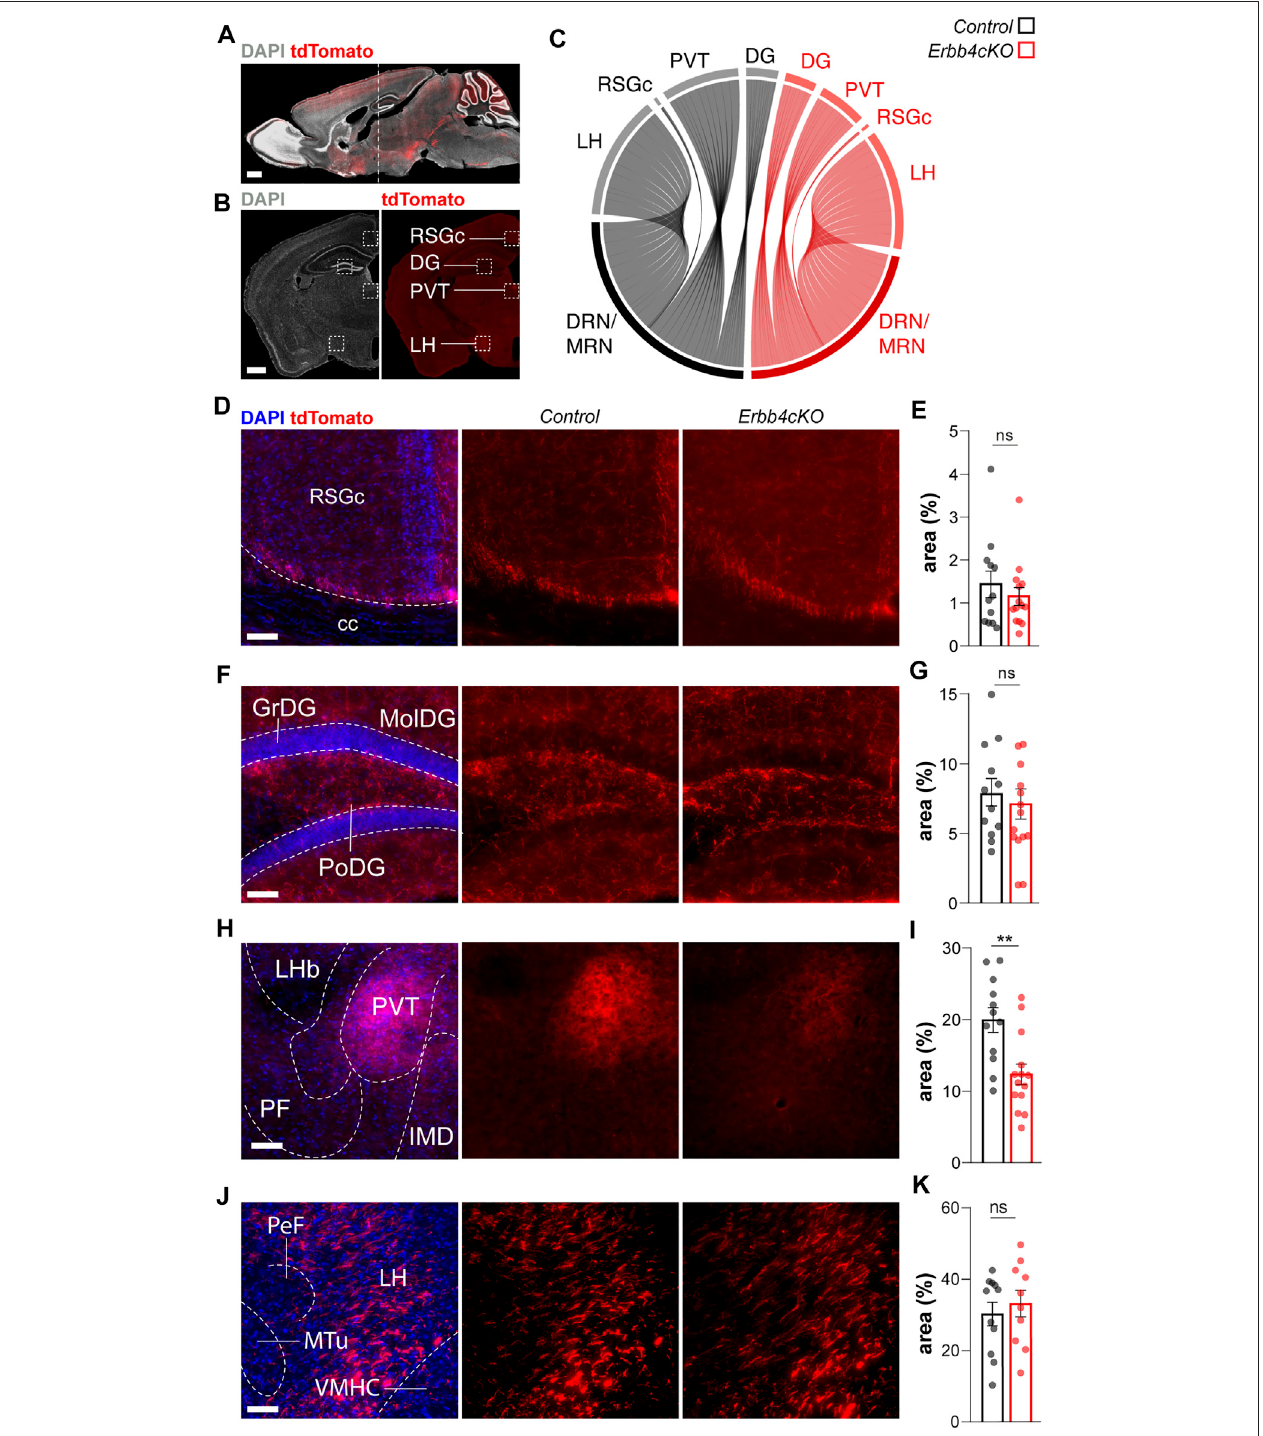
FIGURE 3 | Long-range connectivity de fi cits in ErbB4-de fi cient Pet1 + neurons ofmale and female mice. (A) Pet1 +tdTomato+ cells in a sagittal section ofa mouse brain. Dashed line indicates the location of the brain regions analysed in coronal sections. (B) Coronal section of an adult Pet1 -reporter mouse showing tdTomato- labelled projections. Dashed squares indicate the location of the brain areas analyzed. (C) Circular plot representing relative connectivity to different brain areas from raphe nucleus(RN) incontrol(black)and Erbb4cKO (red)mice. (D,F,H,J) Confocalimagesof Pet1 +tdTomato+ connectivityfrom raphenucleus todifferentbrain areas for control and Erbb4cKO mice. (E, G, I, K) Quanti fi cation of connectivity area normalized to the fi eld of view are presented as percentage of area occupied by tdTomato signal (area%) ( n (cid:2) 11 – 12 control and n (cid:2) 10 – 15 mutant from 3 different litters). RSGc: retrosplenial granular cortex c region; cc: corpus callosum; GrDG: